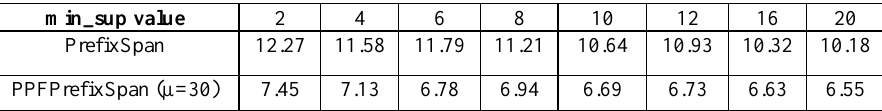
Fig. 1. Comparison diagram of execution efficiency. Table 2. Perform spatial comparison